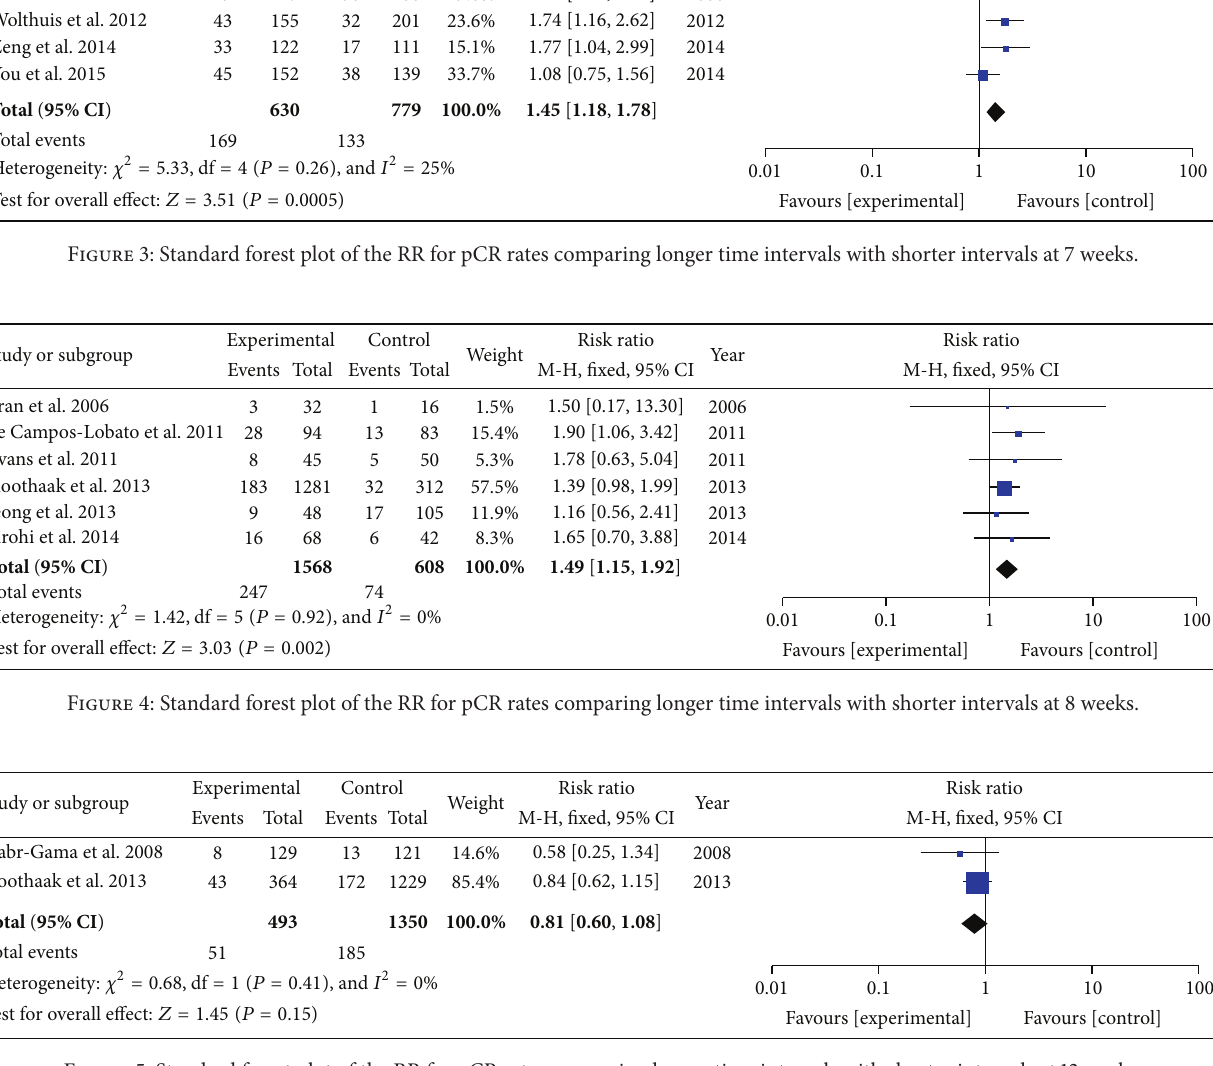
Figure 5: Standard forest plot of the RR for pCR rates comparing longer time intervals with shorter intervals at 12